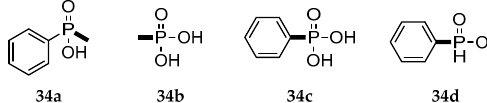
Figure 13. Flame retardant 34a – 34d structures.